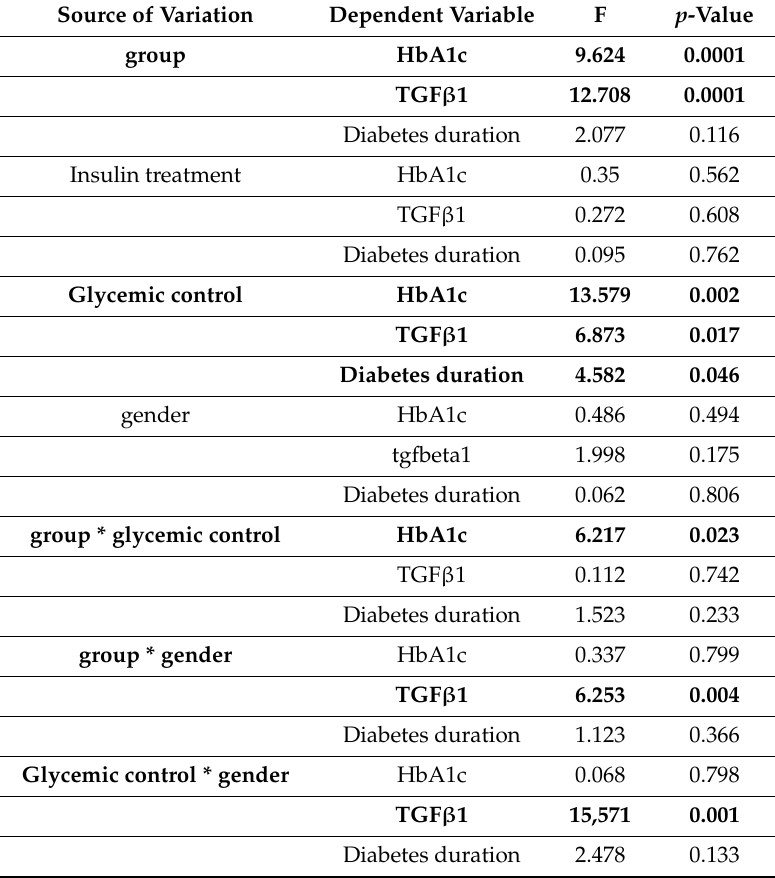
Table 5. Between-subjects e ff ects of M-ANOVA. Bold in order to further highlight statistically significant